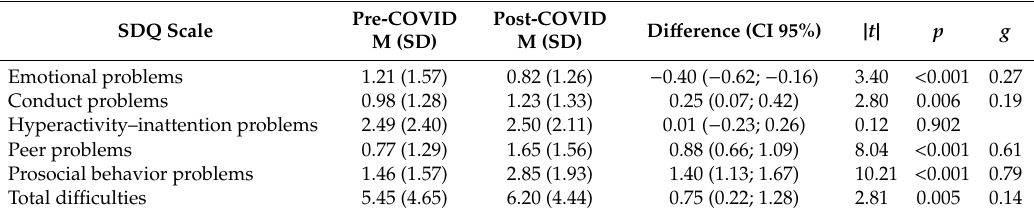
Table 1. Change in the Strengths and Difficulties Questionnaire (SDQ) psychological problems scores between Pre and Post COVID-19 ( N = 197).